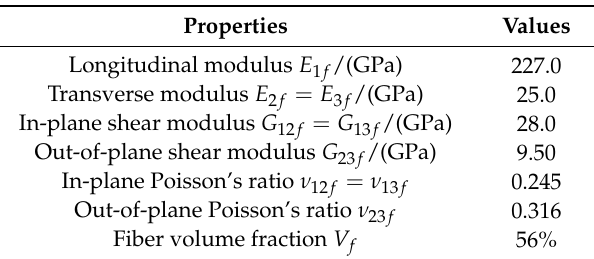
Table 1. Properties of fiber T300 [18].